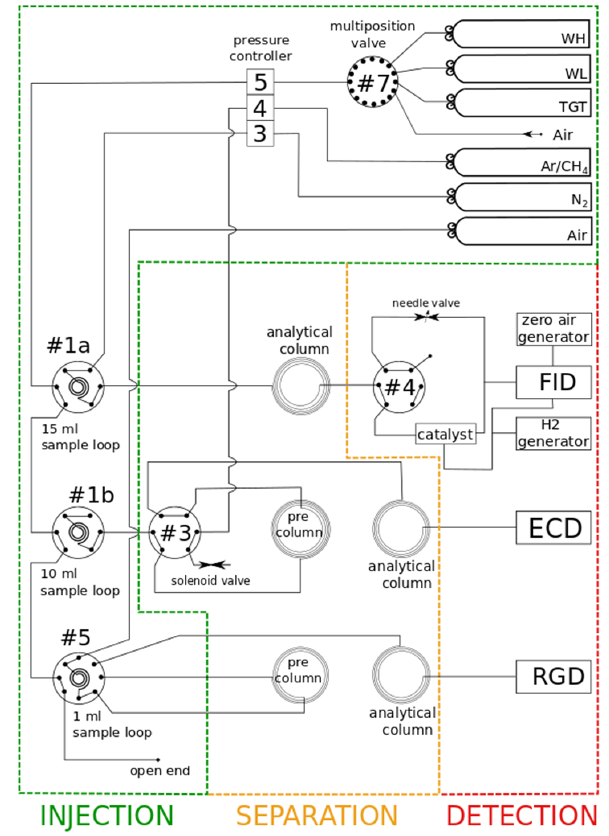
Figure 4. Schematic of the two coupled GC systems. The FID and the ECD detector are housed in a GC 6890N from Agilent Tech- nologies and the reduction gas detector (RGD) in a PP1 from Peak Laboratories. The three sample loops are flushed with the same sam- ple and injected at the same